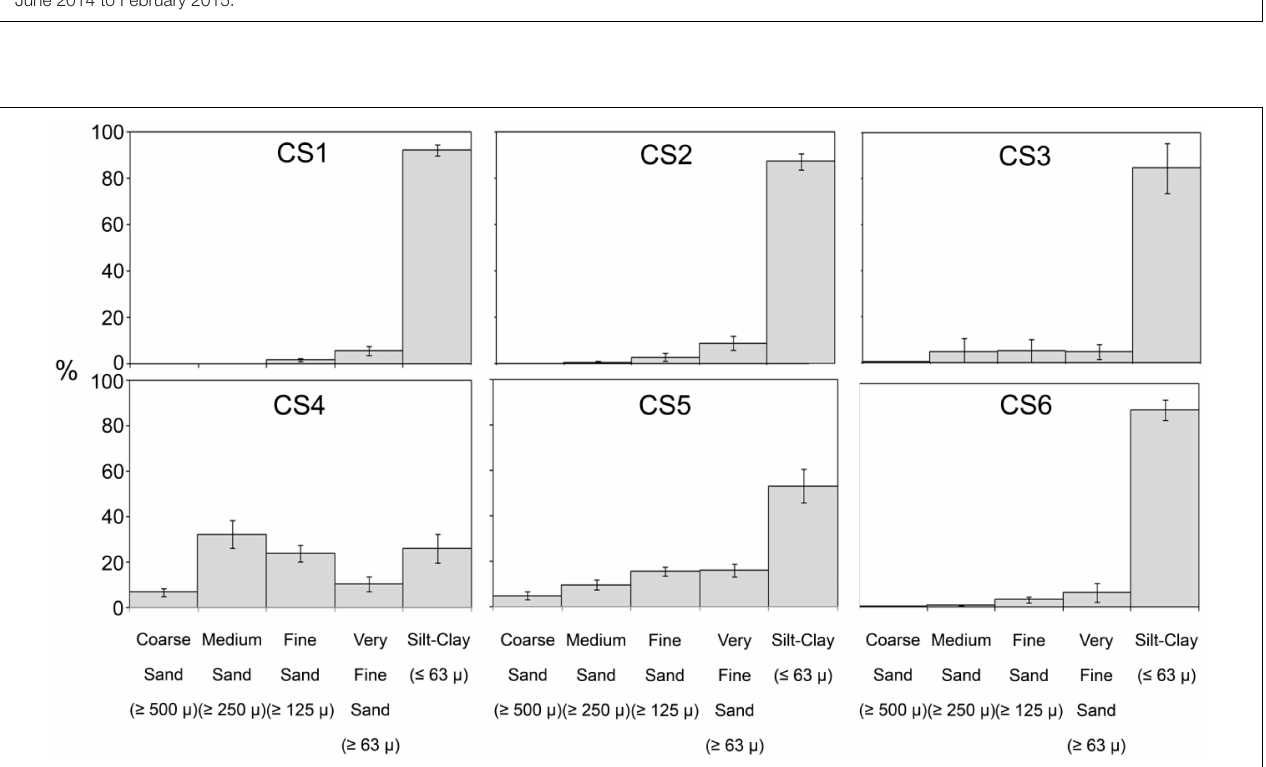
FIGURE 5 | Sediment composition across the sampling stations in the lagoon for study period. Observed size classes of sediment particles have been grouped following Wentworth scale.